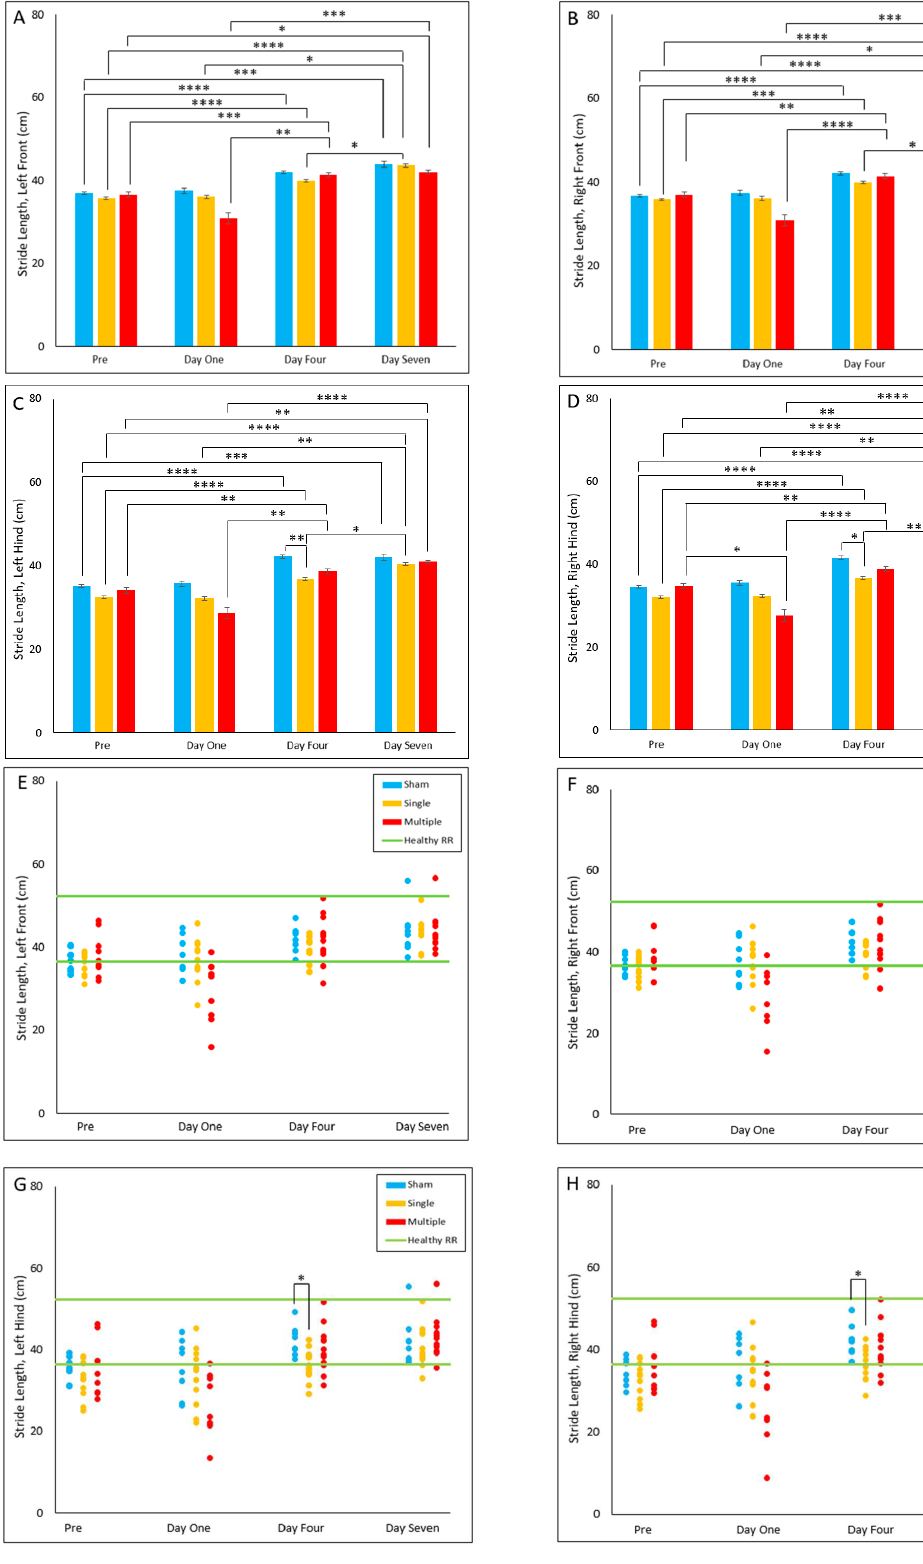
Figure 7. Stride Length by Limb ( A – D ) Presents daily group average ± standard error and statistical comparisons noted from the two-way ANOVA with repeated measures analysis; ( E – H ) Presents individual animal daily averages with statistical comparisons noted from the Fisher Exact Test and McNemar’s analysis (* p < 0.05, ** p < 0.01, *** p = 0.001, **** p < 0.001). In all four limbs, the sham and single injury group experienced an increase in stride length from pre-injury to Day Four ( p ≤ 0.001) and Day Seven ( p ≤ 0.001). Within the single injury group, we also noted a significant increase in stride length of all limbs on Day One ( p ≤ 0.016) and Day Four ( p < 0.04) relative to Day Seven (Figure 7A–D). In all four limbs, the multiple injury group experienced an increase in stride length from pre-injury to Day Four ( p ≤ 0.007). Additionally, in the multiple group a significant increase from pre-injury to Day Seven ( p ≤ 0.031) was observed in all limbs except for the right front (RF). Only the right hind (RH) limb experienced a significant decrease in stride length from pre-injury to Day One ( p = 0.029) in the multiple injury group. All four limbs also displayed an increase in stride length on Day Four ( p ≤ 0.003) and Day Seven ( p ≤ 0.002) relative to Day One (Figure 7A – D). No significant differences were found for reference range comparisons in either front limb, i.e., left front (LF) and right front (RF). However, in both hind limbs, i.e., left hind (LH) and right hind (RH), the single injury group had a decreased proportion of animals in the reference range relative to the sham group ( p = 0.018) (Figure 7E–H). 5. Discussion 5.1. General Summary